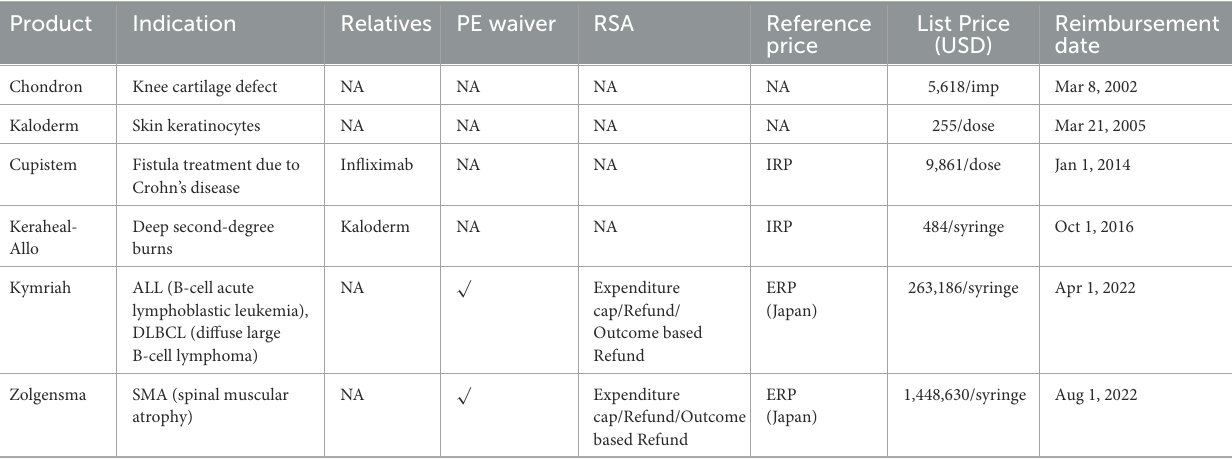
TABLE 5 Reimbursed cell and gene therapies in South